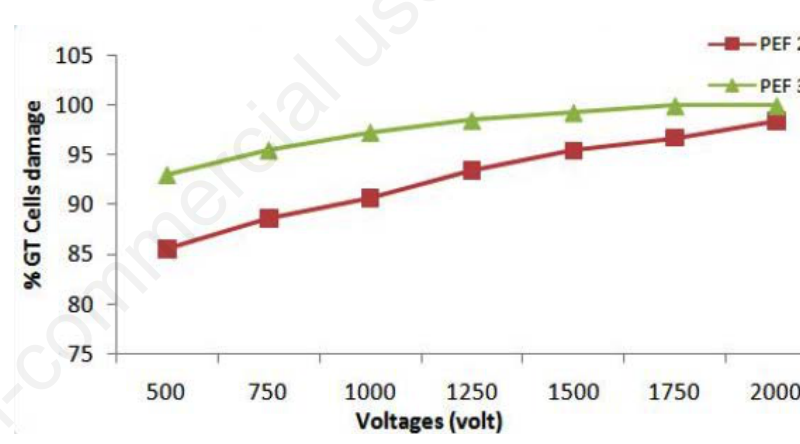
Figure 2. The number of glandular trichrome cells.